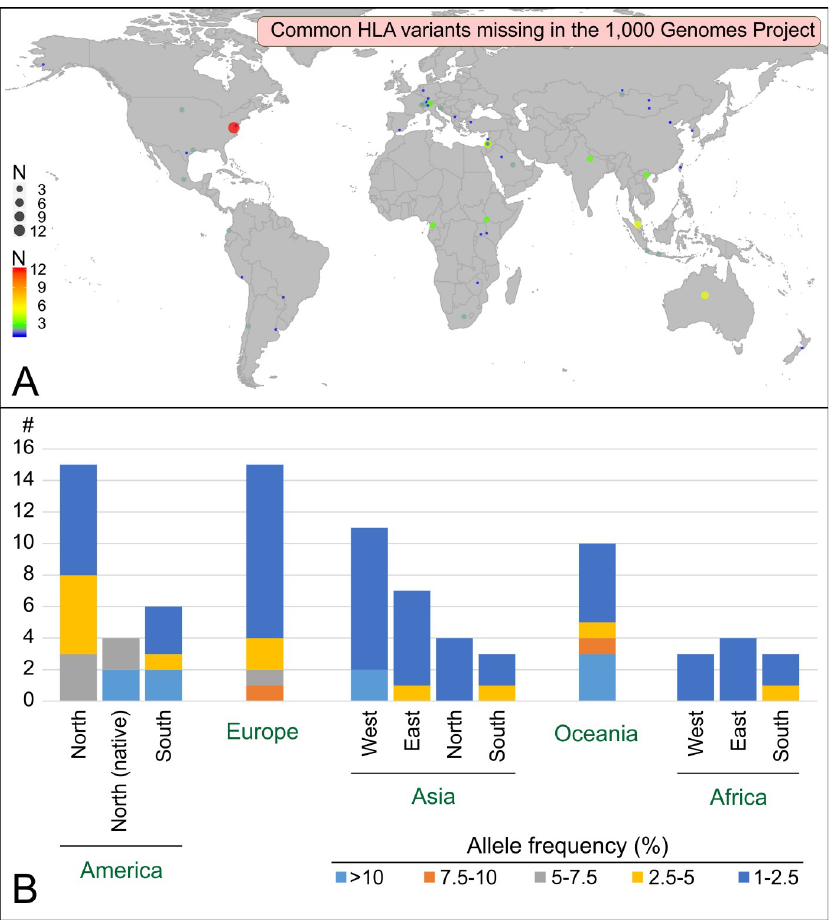
the populations harboring alleles that are missing in the 1,000 Genomes Project. Colors and size of the circles correspond to the number of common alleles observed in each population (scale on the bottom left corner). The map was generated using the ggplot2 package in R [16] and the world database. B. Geographical distribution of the alleles that are missing in the 1,000 Genomes Project. For each region, the number of distinct alleles is given together with their maximum